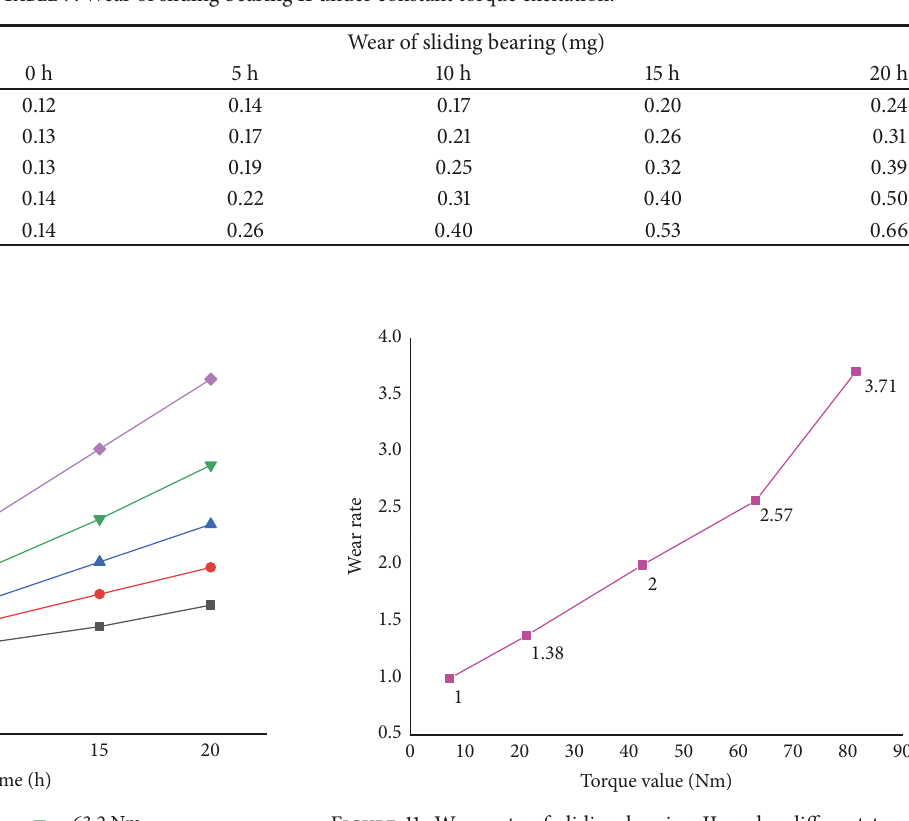
Figure 11: Wear rate of sliding bearing II under different torque